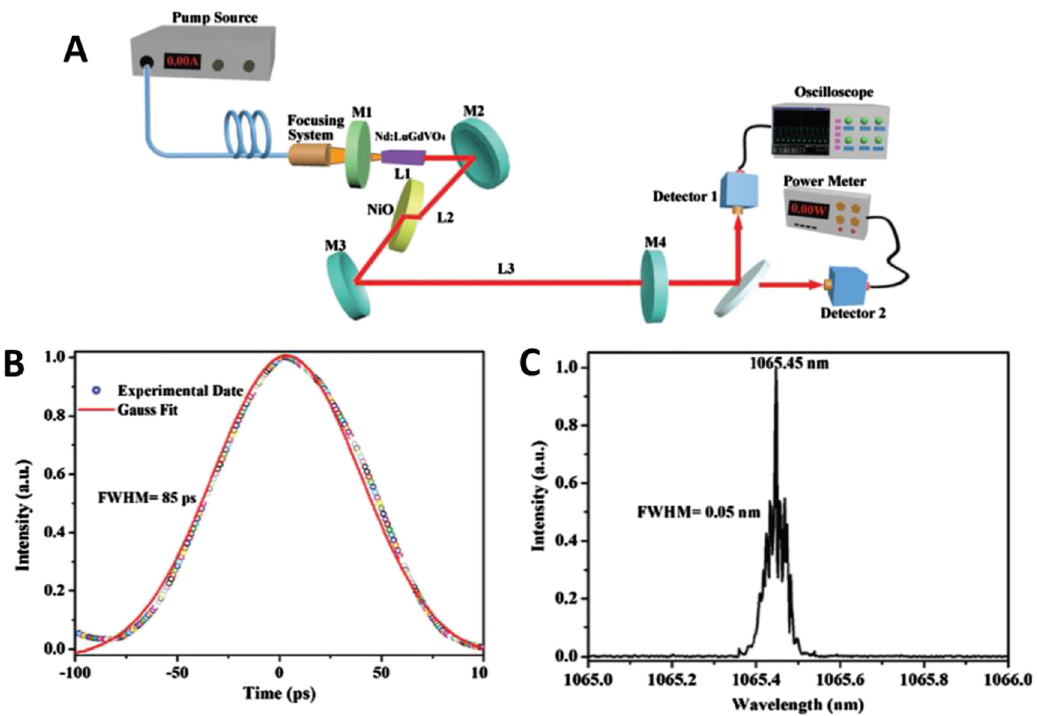
Figure8: (A)Experimentalconfigurationof diodepumpedmode-lockedlaserusingNiOas saturableabsorber.(B)Singlepulseand(C)output spectrum centered at 1.06 µm from a mode-locked laser using NiO nanosheetsas saturable absorber. Reproduced with permission from [64], Copyright (2017) Wiley.